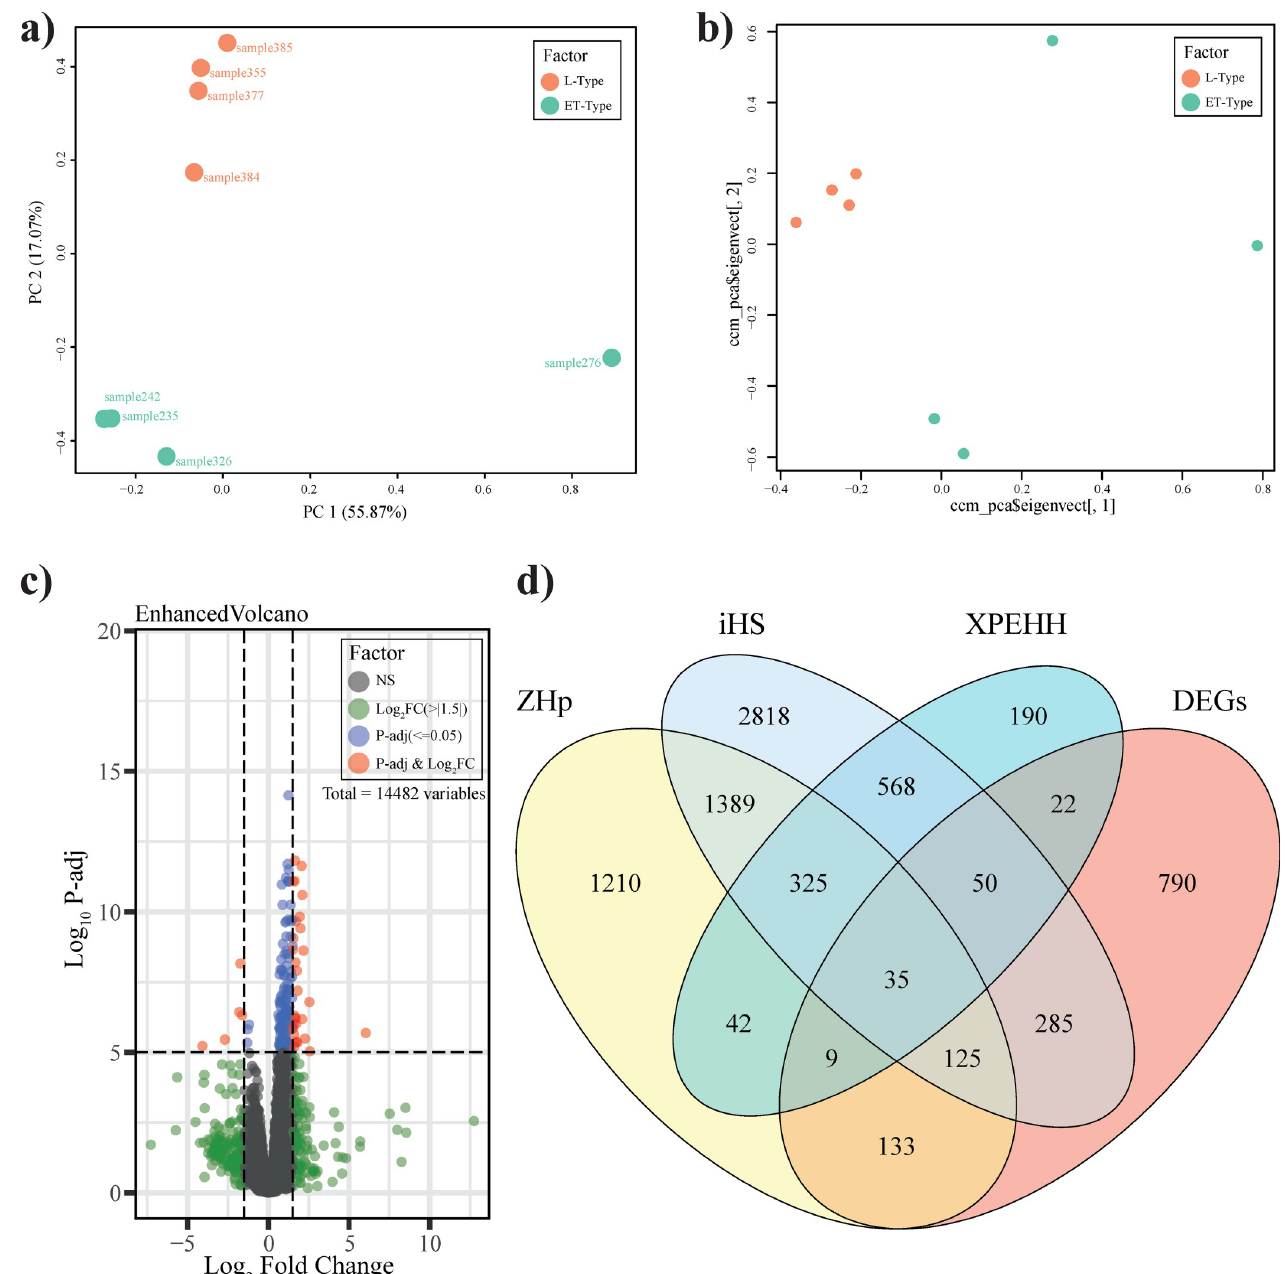
Fig 1. Principal component analysis: (a) & (b) representing the distribution of pig breed variety (L vs ET) in 2-d view. There a clear separation between the breeds can be visualized. (c) Differentially expressed genes visualization was performed using enhanced volcano plot with p.adj � 0.05 and Log2FC � ± 1.5, here NS signifies non-significant genes. (d) Common genes in different condition viz. iHS, ZHp, XP-EHH, and DEGs were visualized using Venny, and 35 common genes were identified.